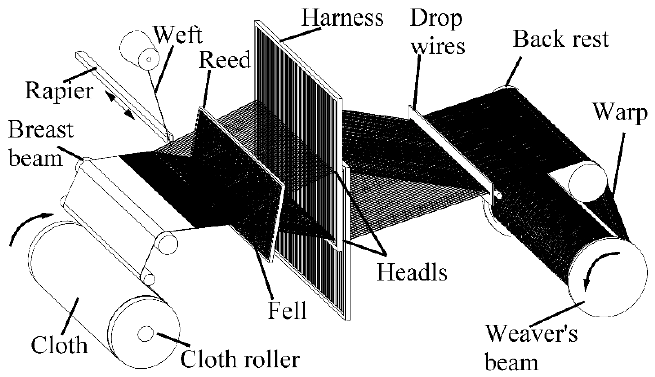
Figure 1. Weaving process diagram for a single rapier loom.